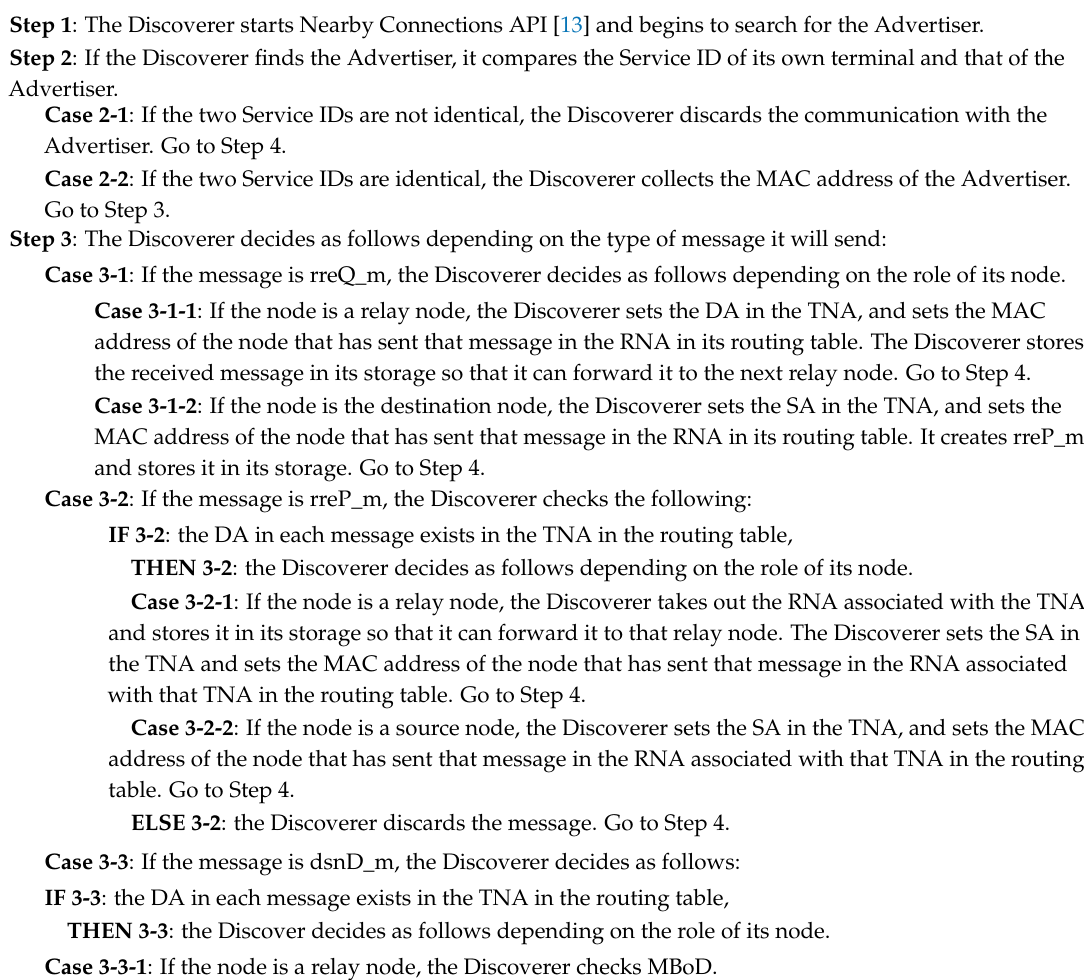
Algorithm 2. Algorithm for Receiving